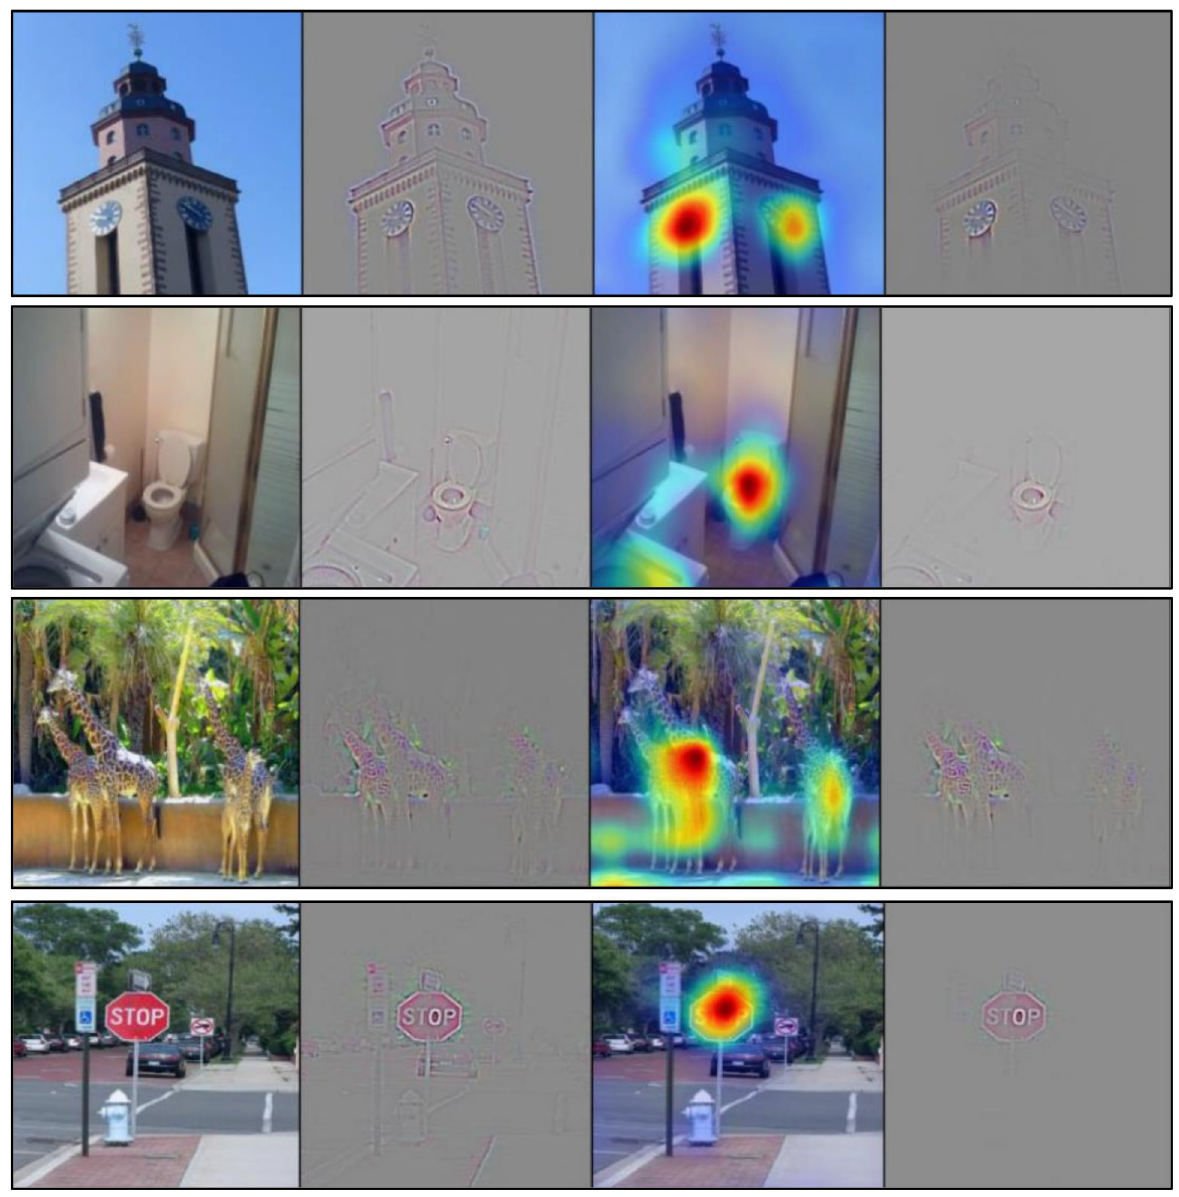
Fig 3. Try to peek into the “black box” where you can. The recognition of objects in images done by Grad-CAMs relies on classification of these objects by programmers. Without the explicit knowledge of what “clocks,” “toilets and sinks,” giraffes, or “stop signs” are, the programmer would not be able to verify the outputs of the Grad-CAM visualization. Mastery of the topic of interest is crucial in the development of such models